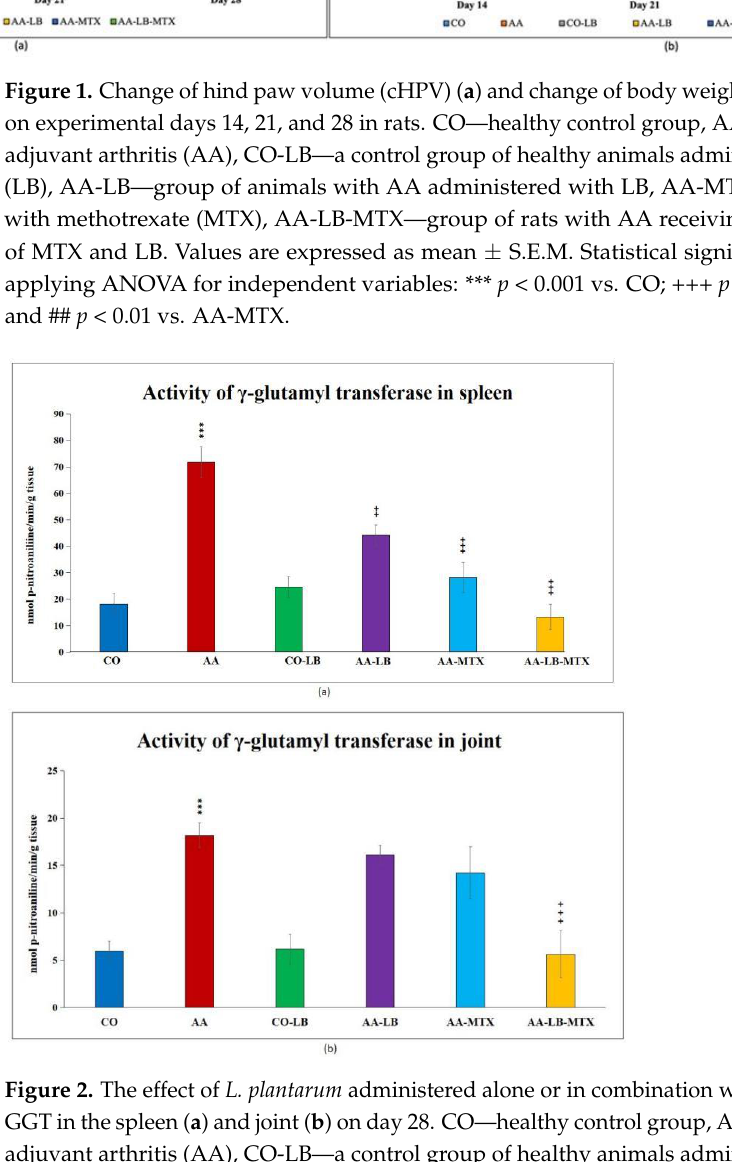
Figure 2. The effect of L. plantarum administered alone or in combination with MTX on the activity of GGT in the spleen ( a ) and joint ( b ) on day 28. CO — healthy control group, AA — group of controls with adjuvant arthritis (AA), CO-LB — a control group of healthy animals administered with L. plantarum (LB), AA-LB — group of animals with AA administered with LB, AA-MTX — rats with AA treated with methotrexate (MTX), AA-LB-MTX — group of rats with AA receiving combinational therapy of MTX and LB. Values are expressed as mean ± S.E.M. Statistical significance was evaluated by applying ANOVA for independent variables: *** p < 0.001 vs. CO; +++ p < 0.001 and ++ p <0.01 vs. AA.